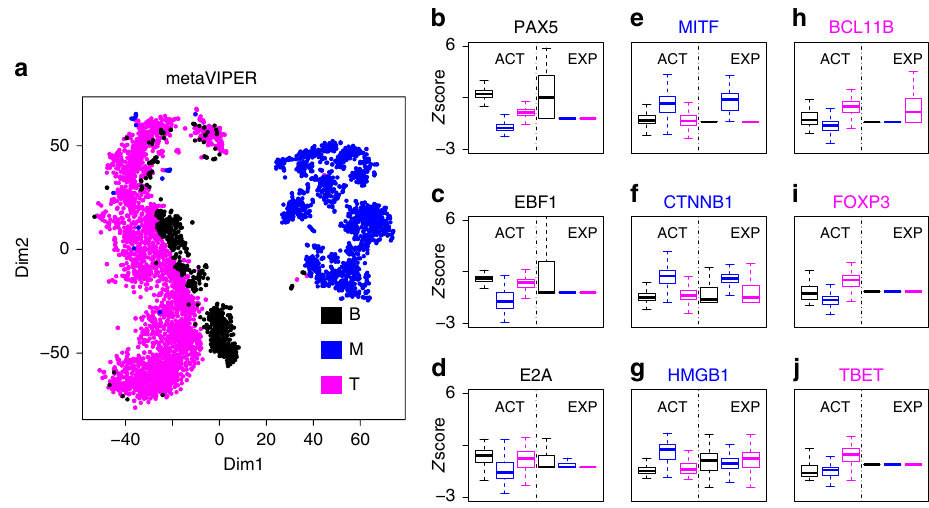
Fig. 3 Inference of protein activity for single cells pro fi led by Tirosh et al . 35 . a Annotated cell types (B: B lymphocyte, T: T lymphocyte, M: melanoma cell) were separated by t-SNE analysis, using metaVIPER-inferred activity for all annotated transcriptional factors, co-transcriptional factors, and signaling proteins. Boxplots show metaVIPER-inferred activity, as well as gene expression for tissue-speci fi c lineage markers, including PAX5 37 , EBF1 38 , and E2A 39 for B lymphocyte ( b – d ), MITF 40 , CTNNB1 41 , and HMGB1 42 for melanocyte ( e – g ), BCL11B 43 , FOXP3 44 , and TBET 45 for T lymphocyte ( h – j ). While these markers are signi fi cantly differentially active in these tissues, they could not be effectively assessed at the single cell level, either because no mRNA reads were detected or because markers were not statistically signi fi cant in terms of differential gene expression. Boxplots showed the median, lower/upper whiskers, and hinges of z- scores